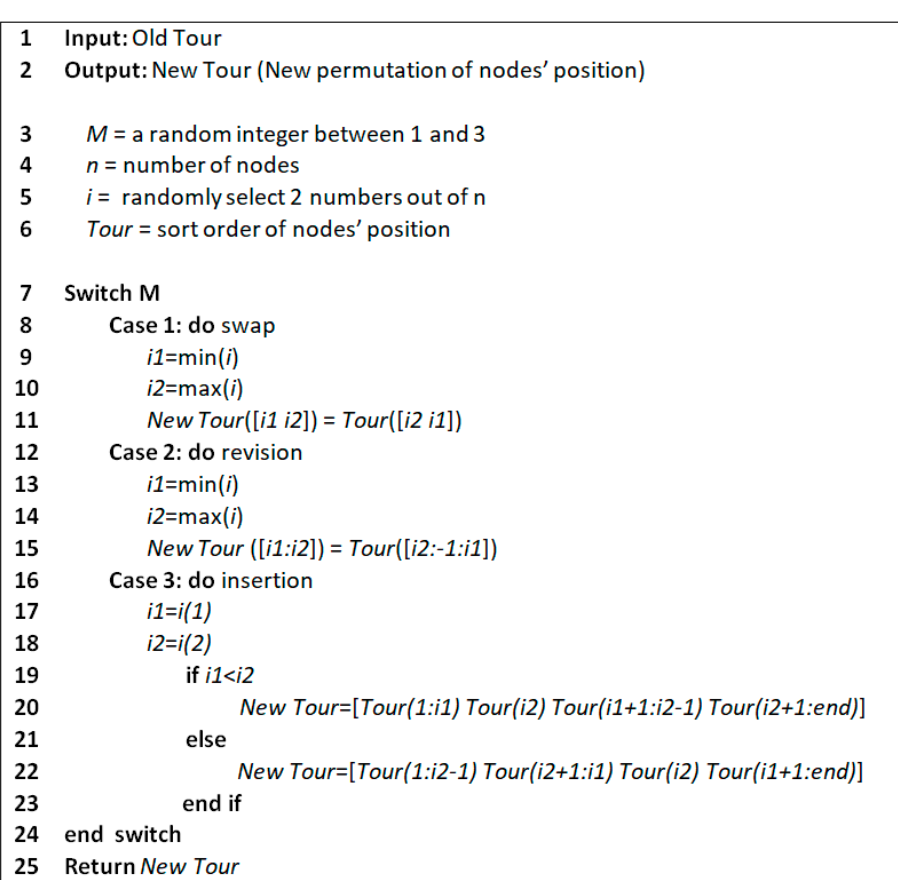
Figure 9. Pseudocode of the utilized mutation operators (swap, reversion, and insertion).